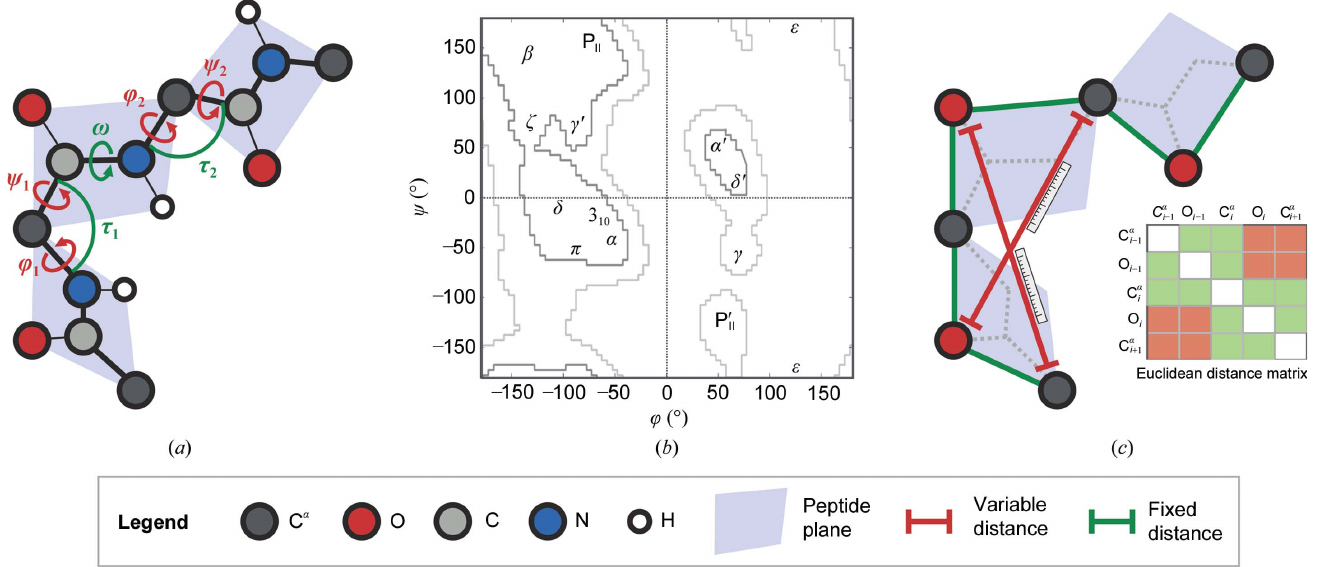
Figure 1 Protein backbone. ( a ) Full-atom representation described by the Ramachandran ’ and angles (in red); the ! torsion and (cid:3) stretching angles are also shown (in green). ( b ) The joint distribution of the Ramachandran ’ and angles with the allowed (light grey) and favoured (dark grey) regions according to Lovell et al. (2003); the nomenclature of different regions is according to Hollingsworth & Karplus (2010). ( c ) Five-atom (double-plane) representation with the conformationally variable interatomic distances shown in red; the distance-geometry based concept used in this work is depicted by a 5 (cid:6) 5 interatomic distance